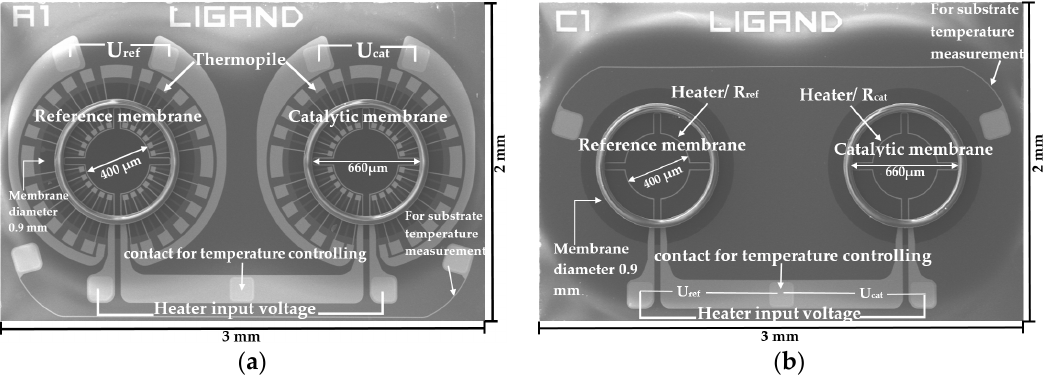
Figure 3. SEM image of the top view of ( a ) the thermoelectric sensor (sensor output = U cat − U ref ) and ( b ) thermoresistive sensor (sensor output is Δ R cat = Δ U cat /I s where I s is the current flows through the heater).